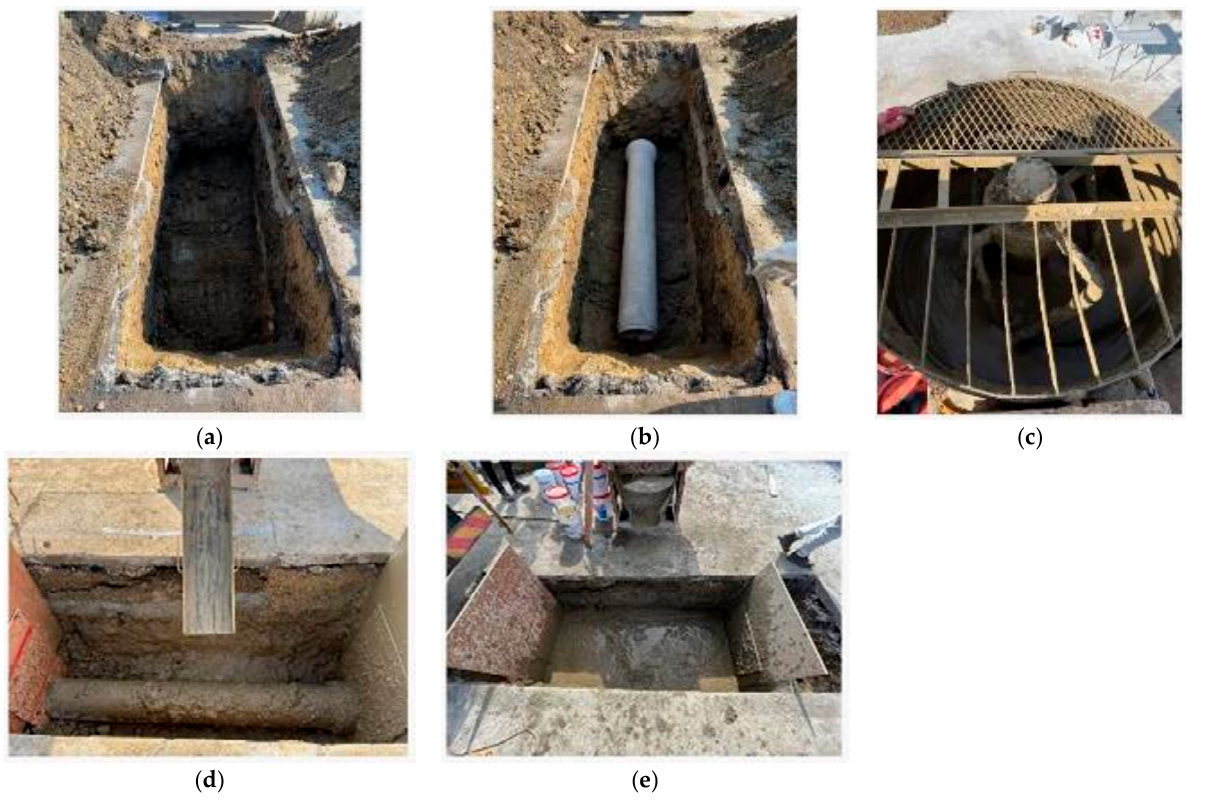
Figure 10. Photographs of the field applicability evaluation of the CLSM using stone sludge. ( a ) excavation; ( b ) pipe landfill; ( c ) CLSM mixing; ( d ) pouring; ( e ) construction completed. Table 5. Hardness test results for the CLSM using stone